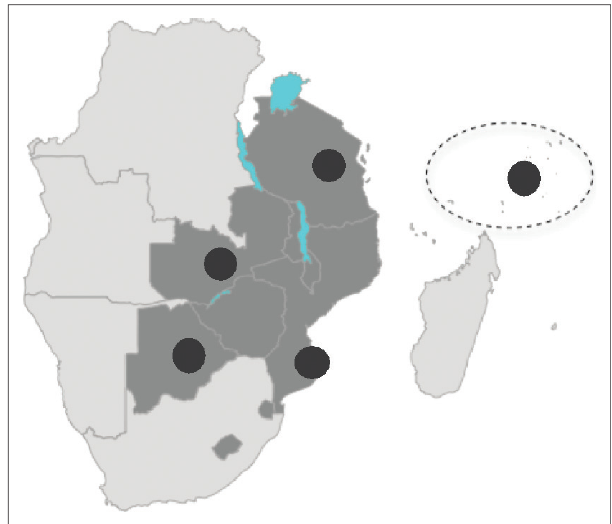
FIGURE 1: The selected cases (black dots) among countries previously identified as having parallel structures for disaster risk reduction and climate change reduction (dark grey) within the SADC